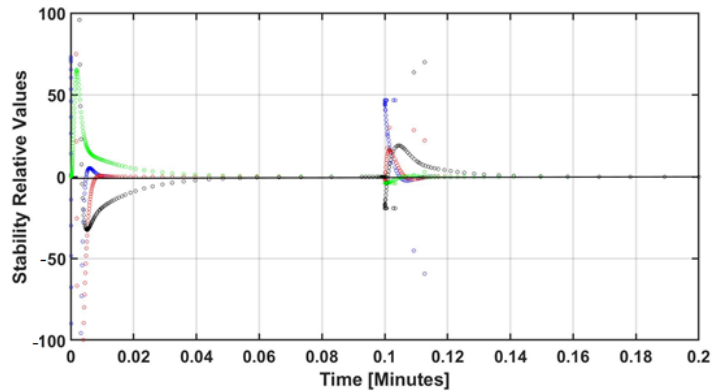
Figure 8. Relative stability values for uncontrolled concentrations (red—compound A; blue—compound B; green—compound C; black—compound